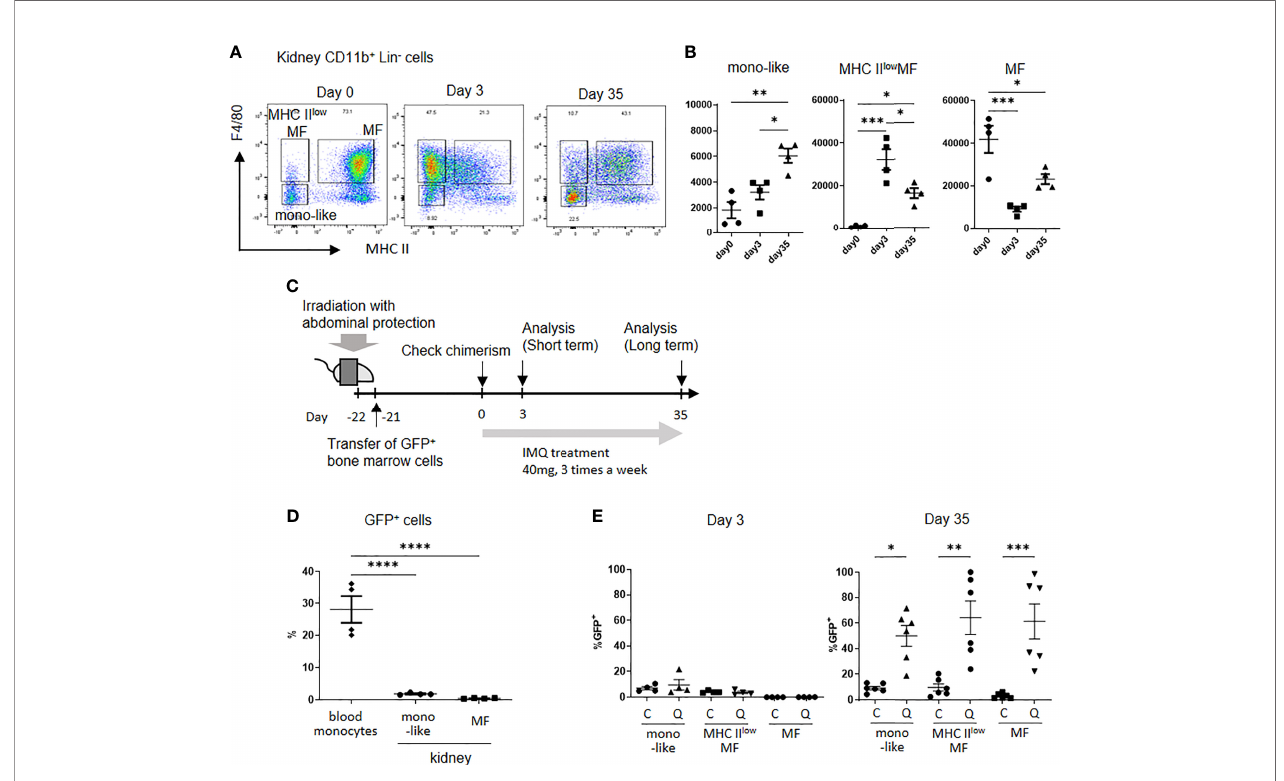
FIGURE 3 | Kidney monocyte-like cells and MF are replaced by peripheral blood cells after the long-term application of IMQ. (A) Representative plot of kidney CD11b + Lin - cells from control (left), short-term IMQ treatment (middle), and long-term IMQ treatment (right) mice. In the short-term analysis, mice were treated with 40 mg of IMQ on days 0 and 2 then sacri fi ced on day 3. In the long-term analysis, mice were treated with 40 mg of IMQ three times a week for 35 days. (B) The change in kidney monocyte-like, MHC II low MF (MHC II lo F4/80 + ), and MF (MHC II hi F4/80 + ) cells at 3 and 35 days after the application of IMQ. (C) Kidney-protected GFP - mice were irradiated and GFP + cells were transferred. Three weeks after transplantation, treatment with topical IMQ was started. (D) Percentages of GFP positive cells 21 days after bone marrow transplantation. Partial bone marrow chimera and protection of kidney resident cells were con fi rmed. (E) Percentages of relative GFP + cells in control (C) and IMQ-treated mice (Q) at days 3 and day 35 after treatment. The percentages were adjusted according to the blood GFP + cell ratio. (B, D, E) show the combined data of two experiments. Symbols represent individuals and horizontal lines indicate the mean and SEM. In (B) , the number in the graph represents the number of cells per 100,000 CD45 + cells. *P < 0.05, **P < 0.01, ***P < 0.001, and ****P < 0.0001 by one way ANOVA and post hoc Tukey ’ s multiple comparison test. mono-like: monocyte-like cells, MHC II low MF: MHC II lo macrophage-like cells, MF: